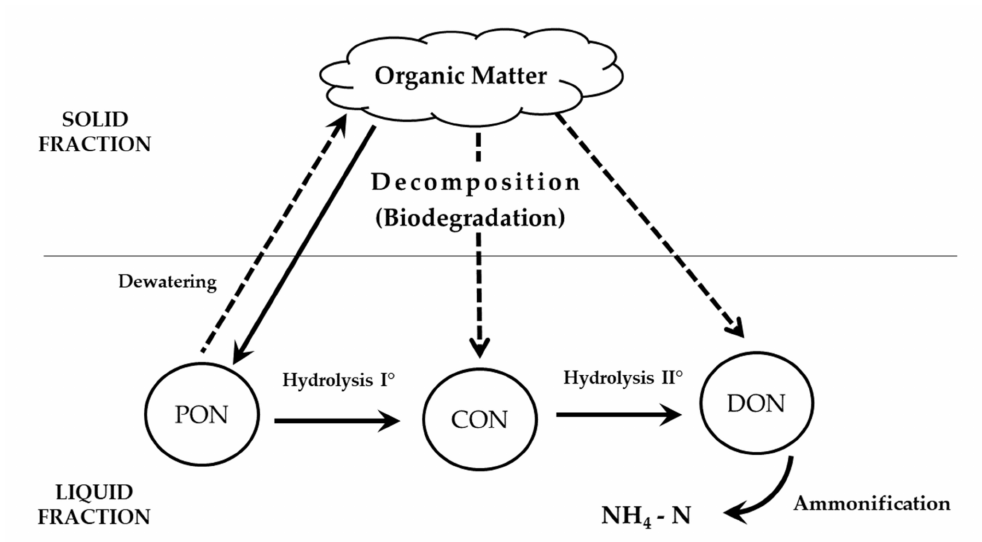
Figure 7. Nitrogen transformation during methane